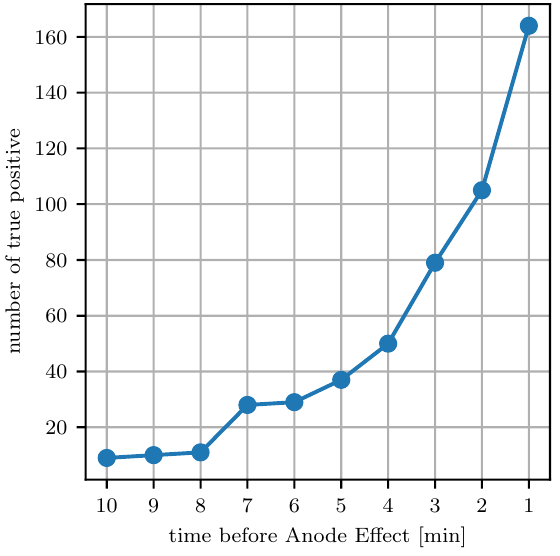
Figure 8. Lead time of